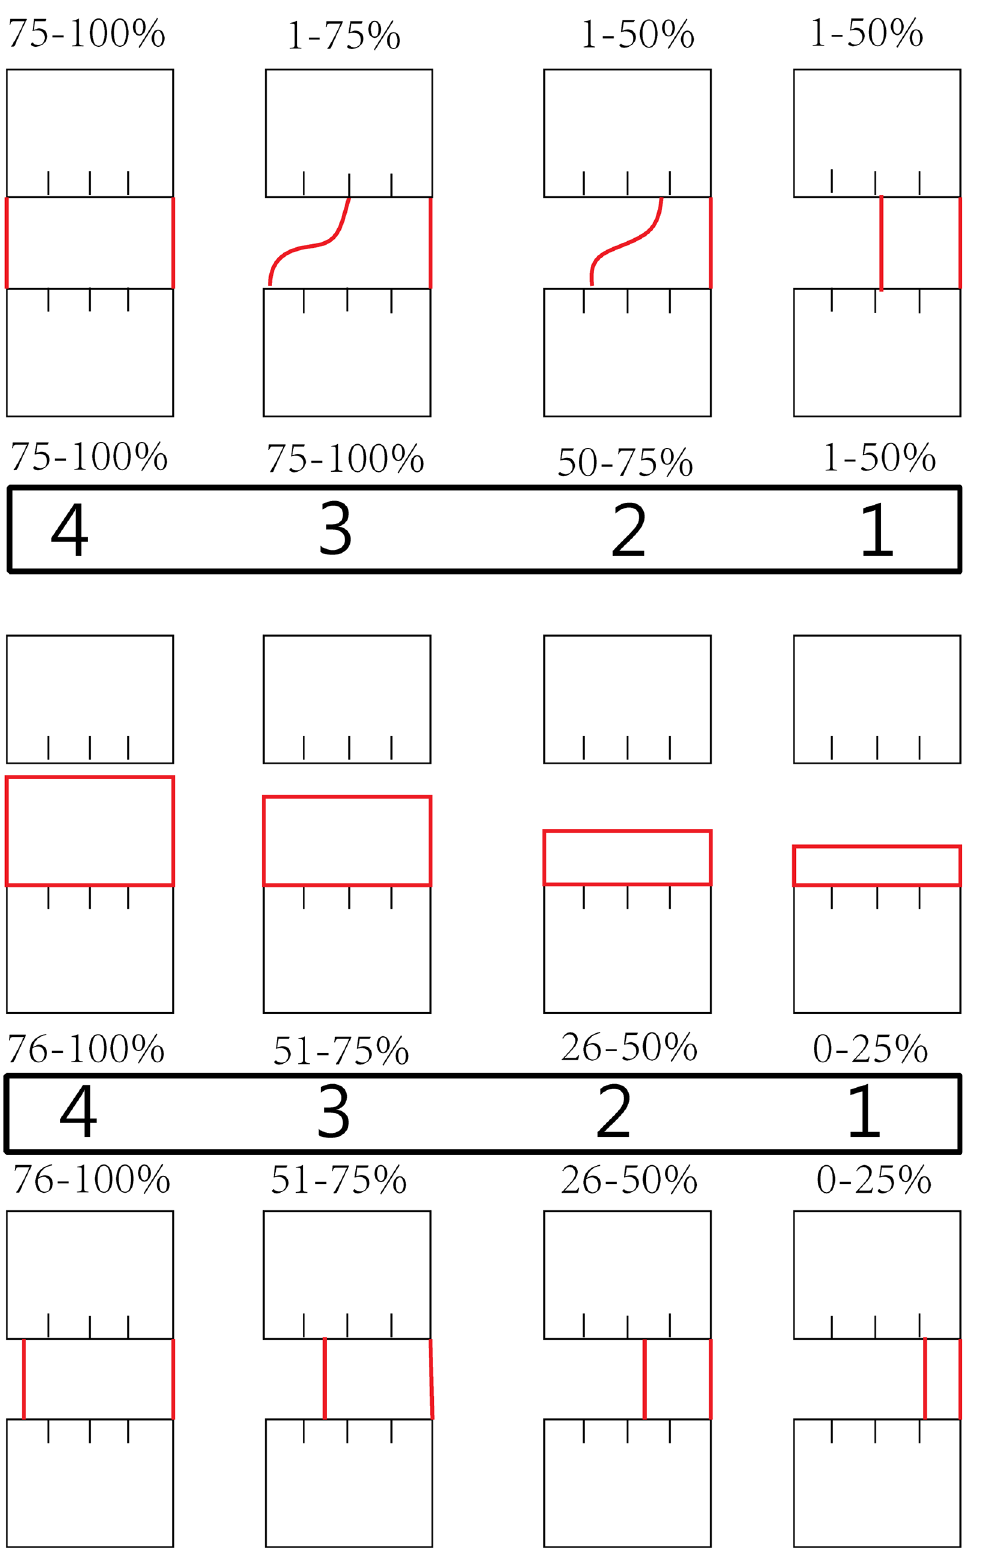
Fig 1. Quantitative evaluation of new bone formation in X-ray and μ CT images for grades. Values refer to the percentage of the given defect border that is bridged by bone tissue of each side of the defect. A score of zero was used when no bone bridging or bone formation was found. doi:10.1371/journal.pone.0146301.g001 PLOS ONE | DOI:10.1371/journal.pone.0146301 January 5,